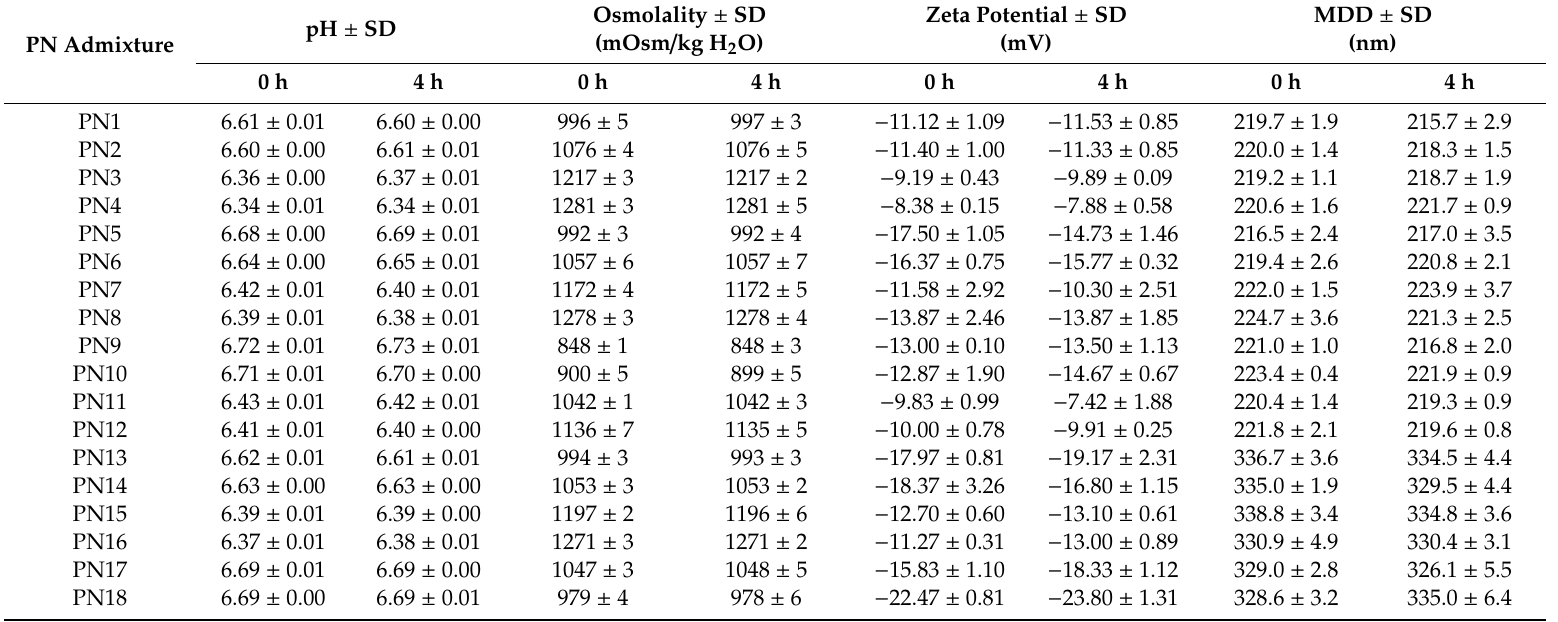
Table 2. Results of pH, osmolality, zeta potential, and particle size of PN